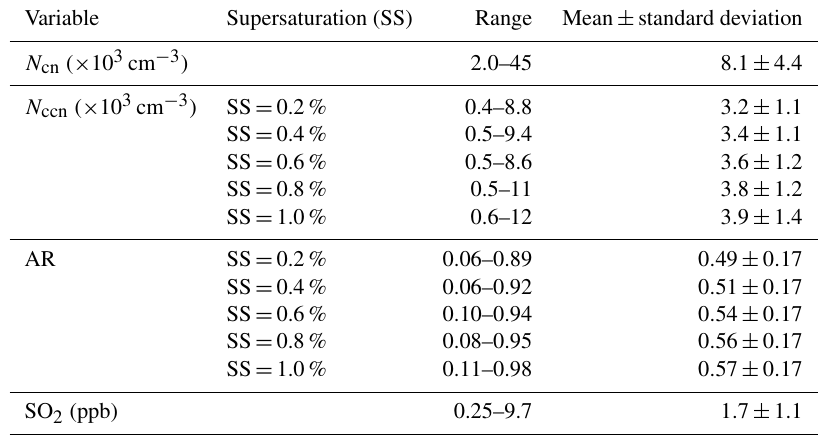
Table 1. N cn and N ccn , AR and SO 2 mixing ratios on DOYs 110–135, 2018, over marginal seas in China. Please note that N cn and AR are from DOYs 110–122,